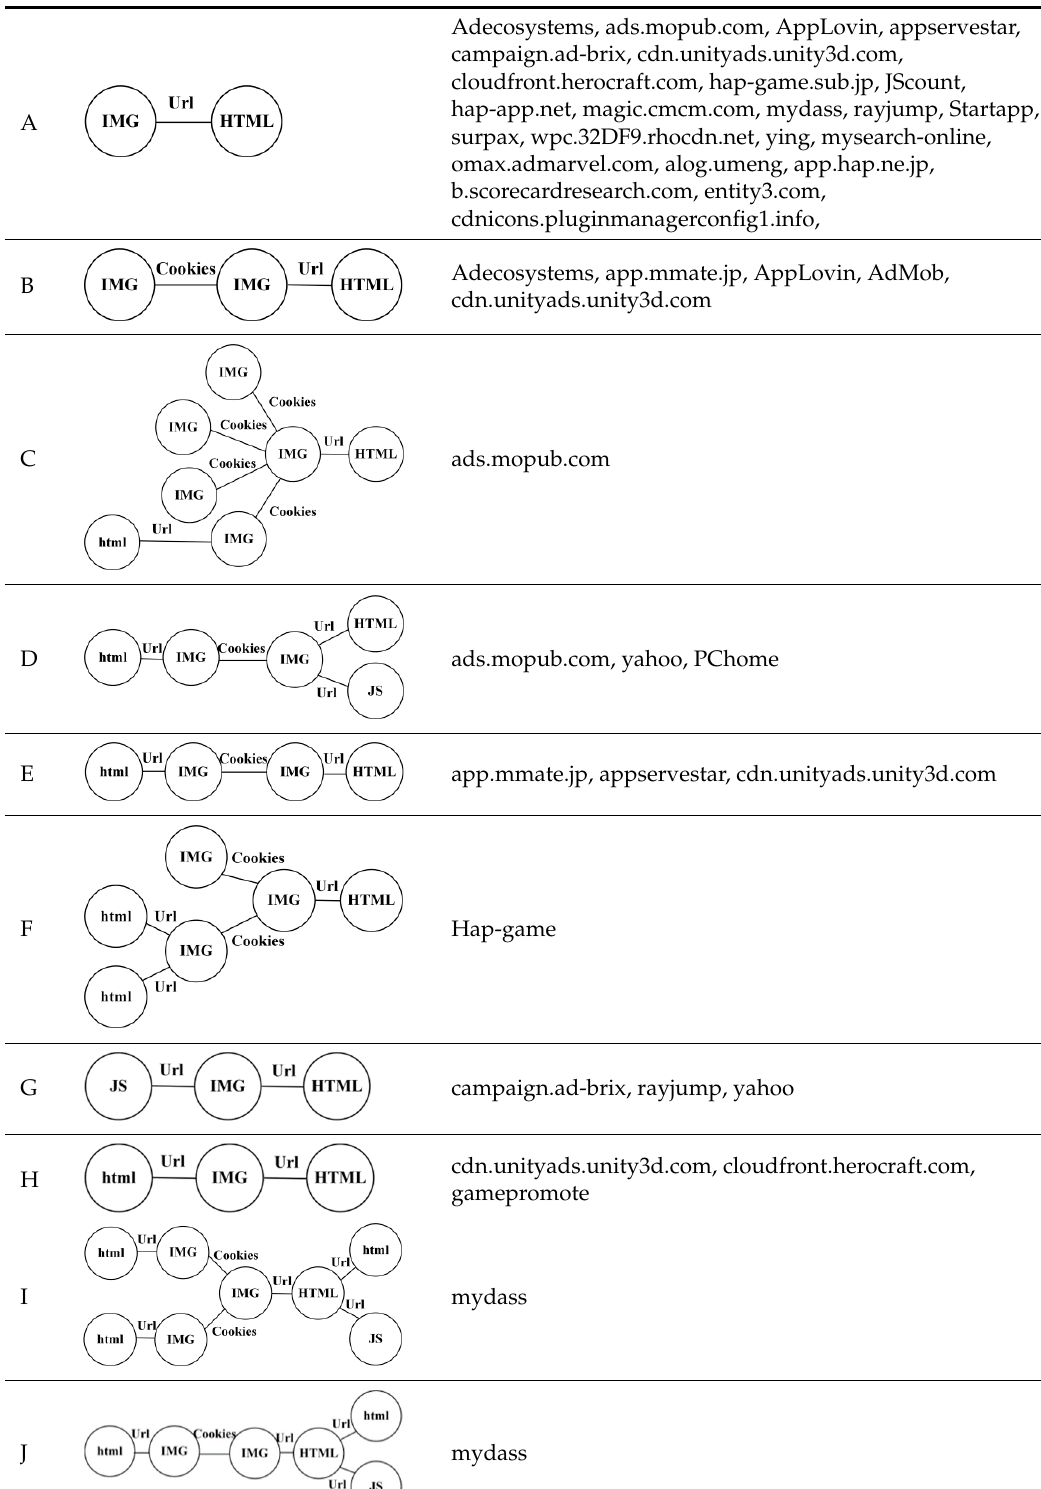
Figure 5. Ad libs’ network behaviors and their graph representations ( a ) MoPub, ( b ) Mmate, ( c ) Hap-game, ( d ) Millennial Media, ( e ) AppLovin. Table 2. Graph types and their corresponding ad libs (with graph as index). Table 1. Advertising behavior graphs of ad libs (with ad lib as index).